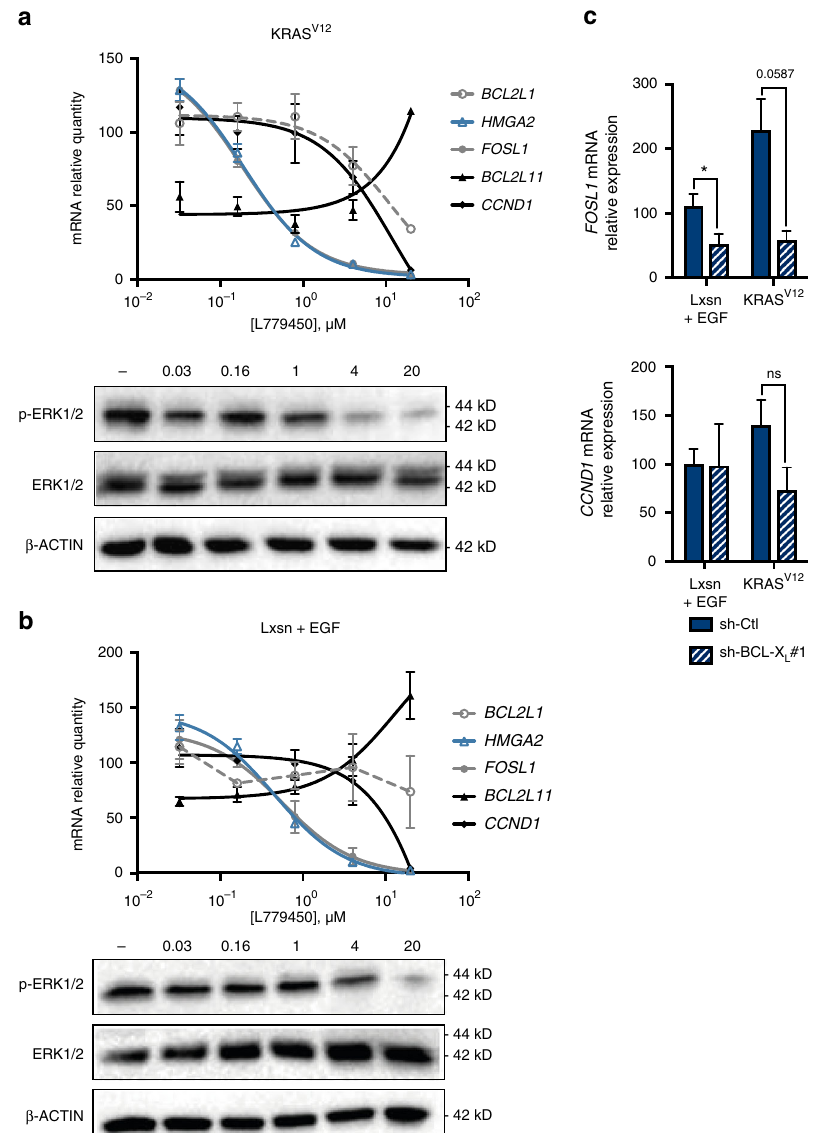
Fig. 4 BCL-X L -dependent RAS target genes expression are sensitive to low dose of RAF inhibitor. a qPCR analysis of BCL2L1 , HMGA2 , FOSL1 , BCL2L11 and CCND1 mRNA in MCF10A KRAS V12 cells treated with increasing doses of RAF inhibitor (L779450) during 24 h. Mean and SEM of 3 independent experiments are represented as relative quantity of mRNA normalised to the mean of RPLP0 , RPS18 and ACTB relative expression. Insert: western blot showing phosphorylation of ERK and total ERK levels under the same conditions. b qPCR of BCL2L1 , HMGA2 , FOSL1 , BCL2L11 and CCND1 mRNA in MCF10A Lxsn cells grown in the presence of EGF treated with increasing doses of RAF inhibitor (L779450) during 24 h. Mean and SEM of 3 independent experiments are represented as relative quantity of mRNA normalised to the mean of RPLP0 , RPS18 and GAPDH relative expression Insert: western blot showing phosphorylation of ERK and total ERK levels under the same conditions. c qPCR of FOSL1 and CCND1 mRNA in EGF-treated MCF10A Lxsn and in MCF10A KRAS V12 cell lines infected with sh-BCL-X L during 72 h. Mean and SEM of 3 independent experiments are represented as relative quantity of mRNA normalised to the mean of ACTB , HPRT1 and GAPDH relative expression (two-tailed unpaired